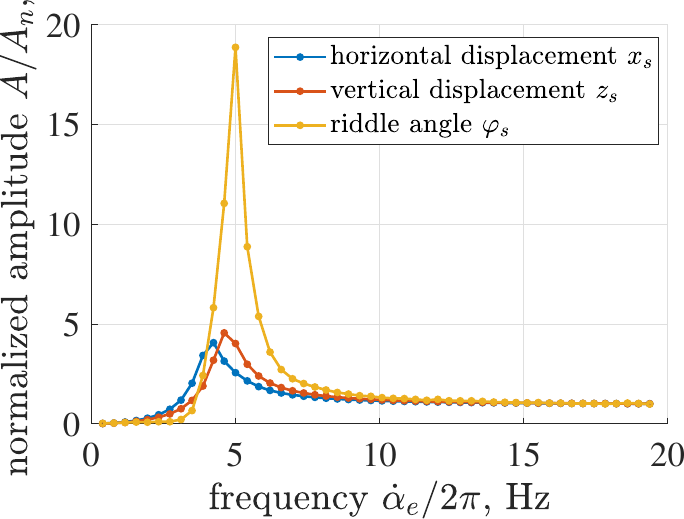
Figure 12. Comparison of non-dimensional normalized amplitudes of horizontal, vertical and angular motion of the vibrating riddle evaluated for the identified screen model in the frequency